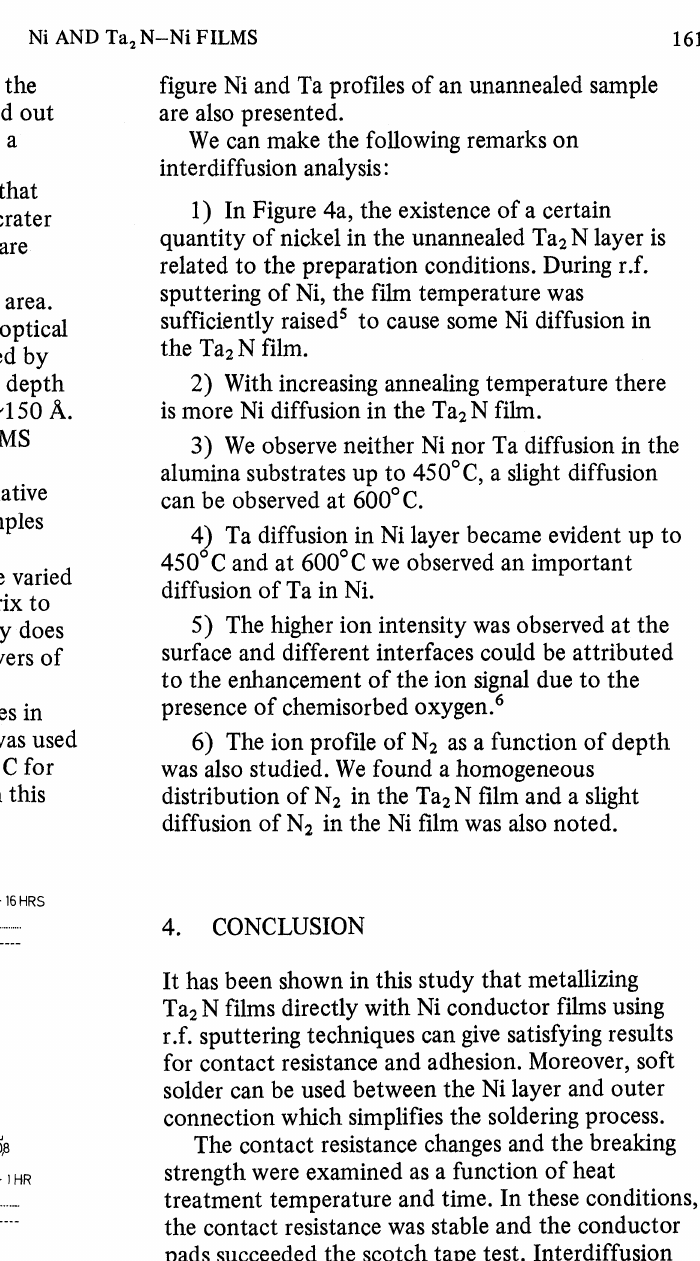
figure Ni and Ta profiles of an unannealed sample are also presented.